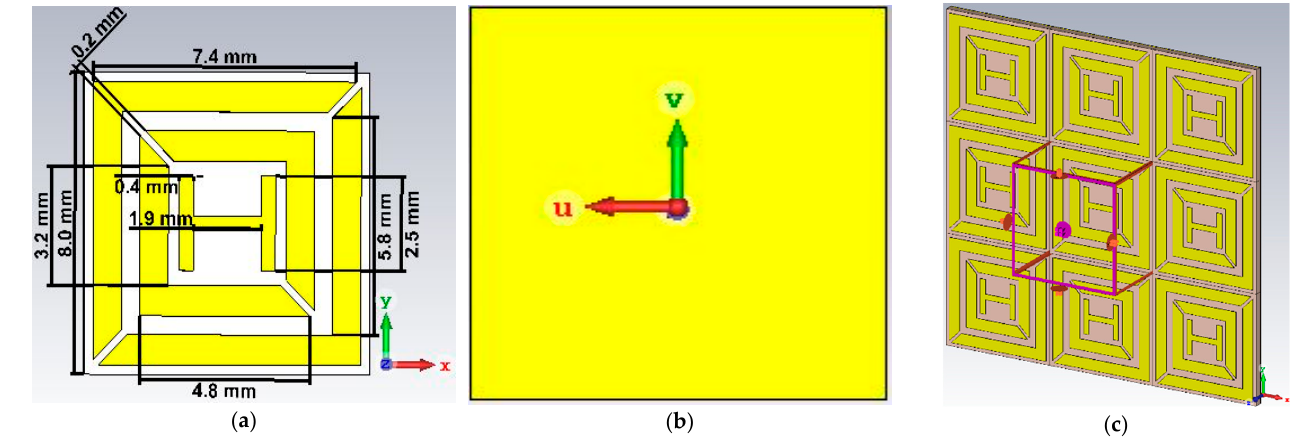
Figure 1. A proposed absorber of ( a ) dimension view; ( b ) back side view; ( c ) simulation view. Models for the metallic resonator and ground plate include copper sheets [30] with electrical conductivities of σ = 5.8 × 10 7 S/m and 0.035 mm in thickness. Because the thickness of the copper sheet utilized in this application is significantly greater than the average skin depth in the microwave frequency range, the only thing preventing the absorption is reflection. The back-side view is indicated in Figure 1b. We selected the Rogers RO4003C (lossy) dielectric substrate for the intermediate layer, as the key benefit of the Rogers 4003C is that it is a low-loss material, with good mechanical strength, two types of glass cloth, and a comparably low cost compared to other substrates. As a result, it possesses excellent electrical and mechanical characteristics, as well as a low Tg (thermal expansion coefficient). It has a thickness of h = 0.58 mm, loss tangent of tan δ = 0.0027, permeability of µ = 1, and permittivity of ε = 3.55. The metamaterial unit cell size is 8 mm × 8 mm. Here, the length and width of the substrate and ground layer are 8 mm in this case, the split gaps of both rings are 0.2 mm, the length and width of the outer ring are 7.5 mm and 5.9 mm, the length and width of the inner ring are 4.9 mm and 3.3 mm, and the length and width of the sub-tracing H-shaped patch are 2.5 mm and 1.9 mm.